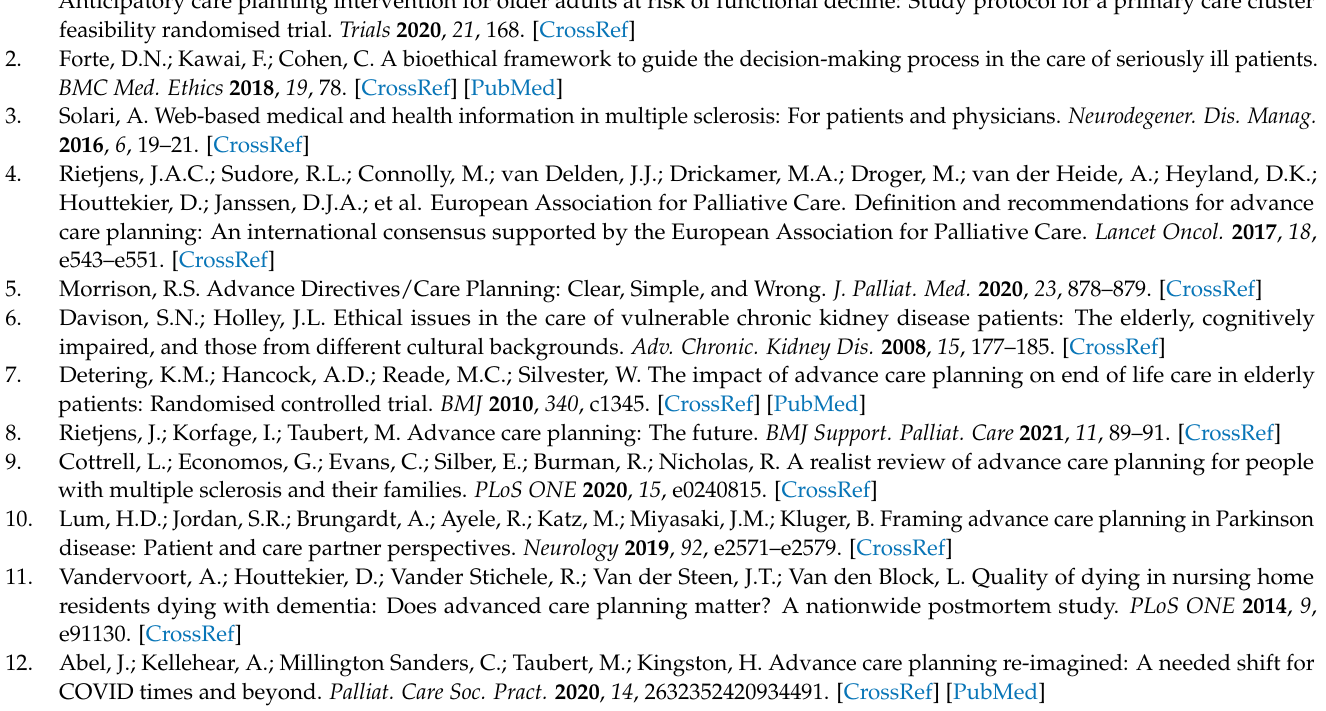
Overview of included studies, Table S2: AMSTAR-2 quality assessment for reviews, Table S3: CASP quality assessment for case-control studies, Table S4: CASP quality assessment for cohort studies, Table S5: CASP quality assessment for qualitative studies, Table S6: Quality assessment for mixed- method studies, Figure S1. Countries and years of publication of included studies. UK is United Kingdom; US is United States, Figure S2: Risk of bias